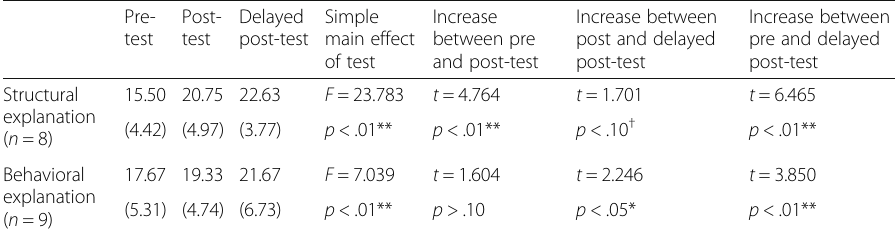
Table 1 Result of tests